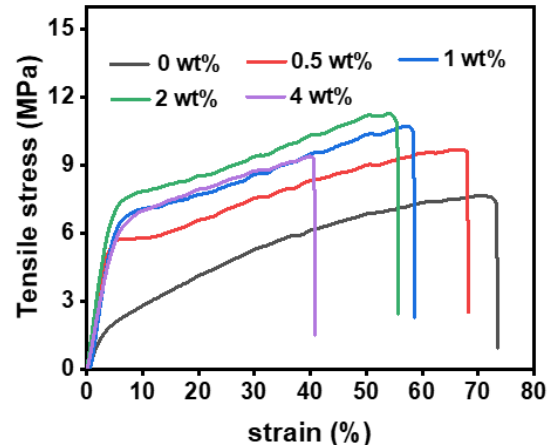
Figure 3. Stress – strain curves of hydrophobically-modified PAN@AMP nanofibrous membranes different concentrations of with different concentrations of AMP.